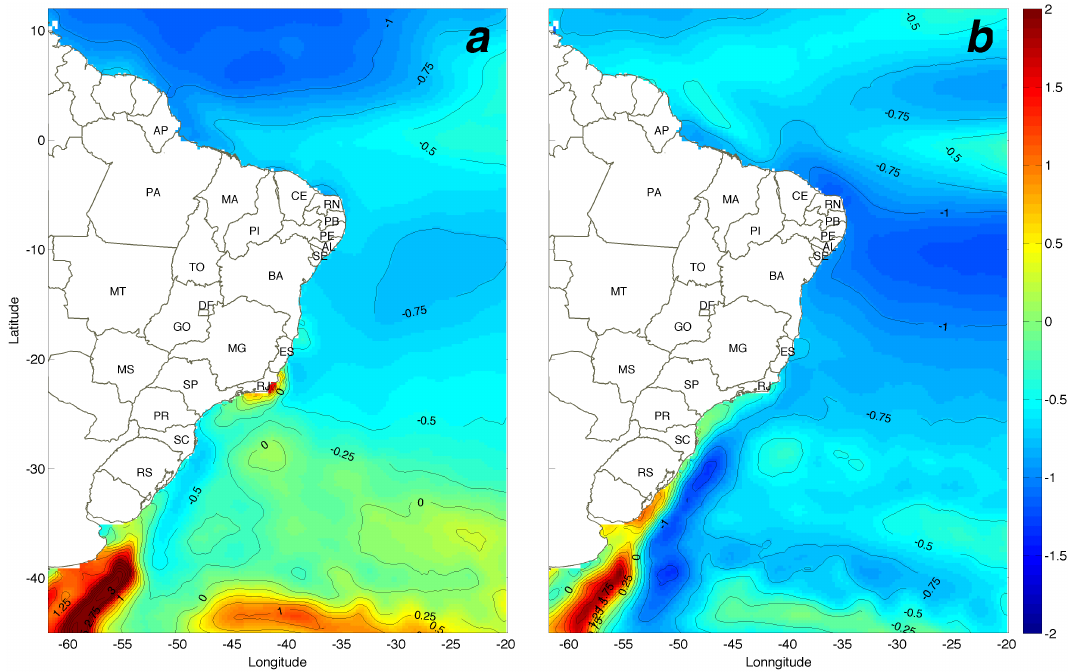
Figure 6. Hub-height wind speed field differences ( U m − U l ) for ( a ) January and ( b ) July, comparing the effect of atmospheric stability on winds vertical extrapolation. U m and U l refer to the winds extrapolated with the stability-based (Monin–Obukhov) and log-law methods, respectively. Contours and colors indicate the speed in m · s − 1 . States names are listed in the legend of Figure